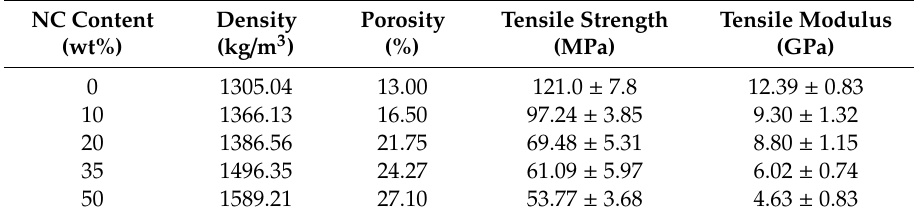
Table 2. Density, porosity, tensile strength, modulus and water contact angles of pure and NC-modified CNF